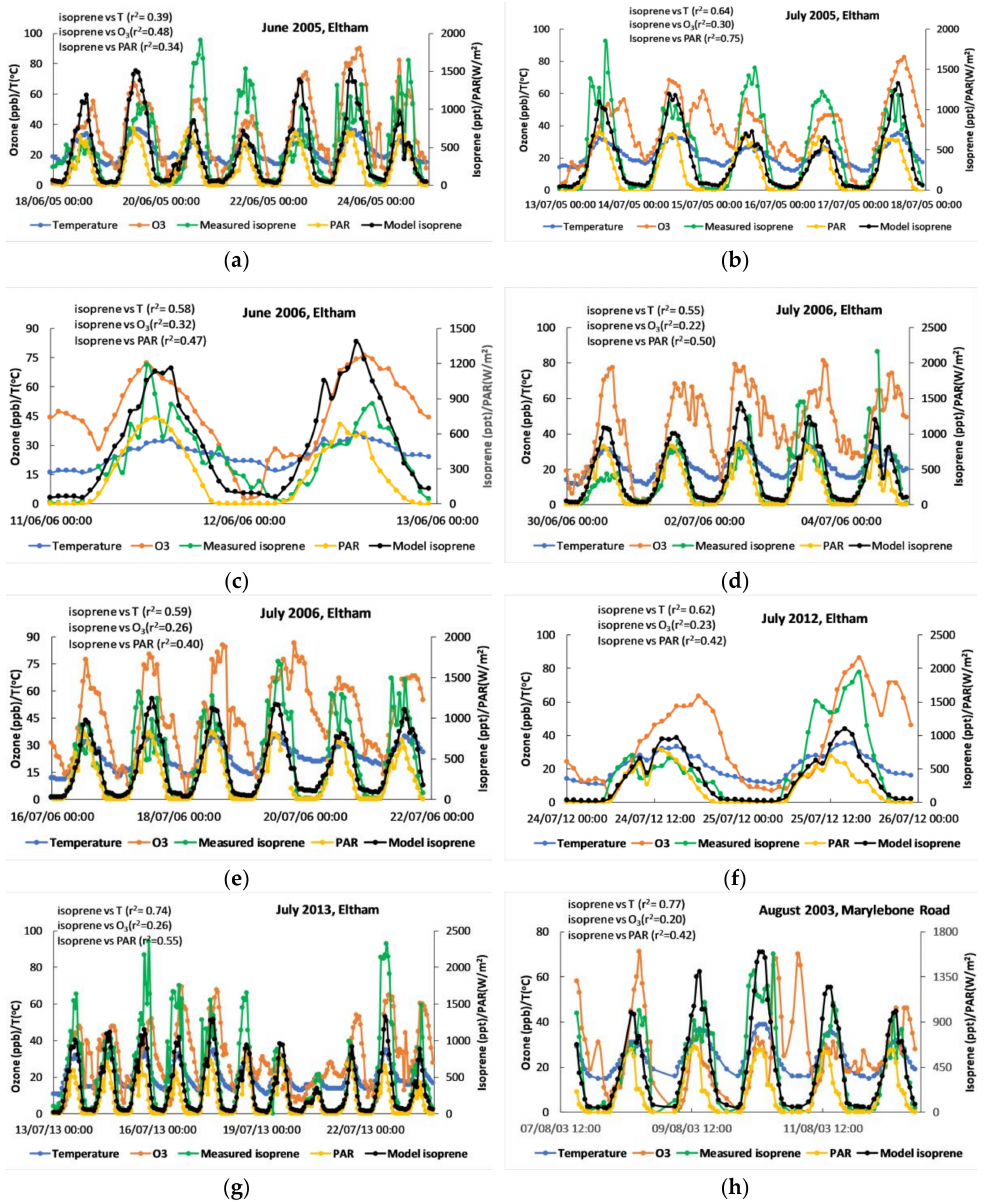
Figure 6. The time series plots of biogenic isoprene and ozone mixing ratios along with temperatures and PAR for the heatwave periods. The estimated isoprene concentrations using Cobb-Douglas model (black line) are also shown in the figure ( a – h